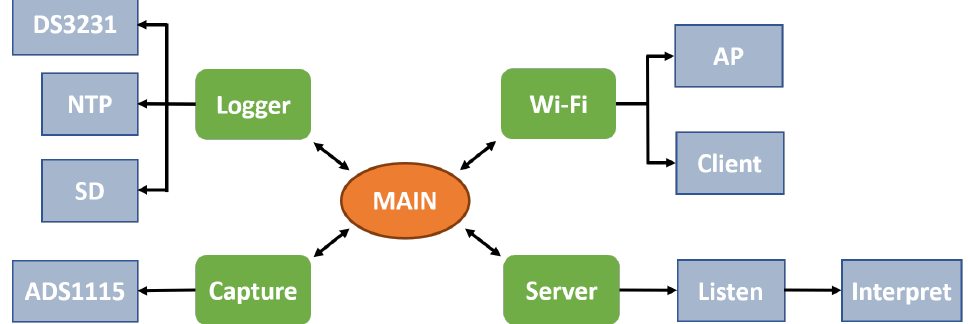
Figure 6. General block diagram of the firmware level operation and main modules: main, logger, capture, WiFi, and server.